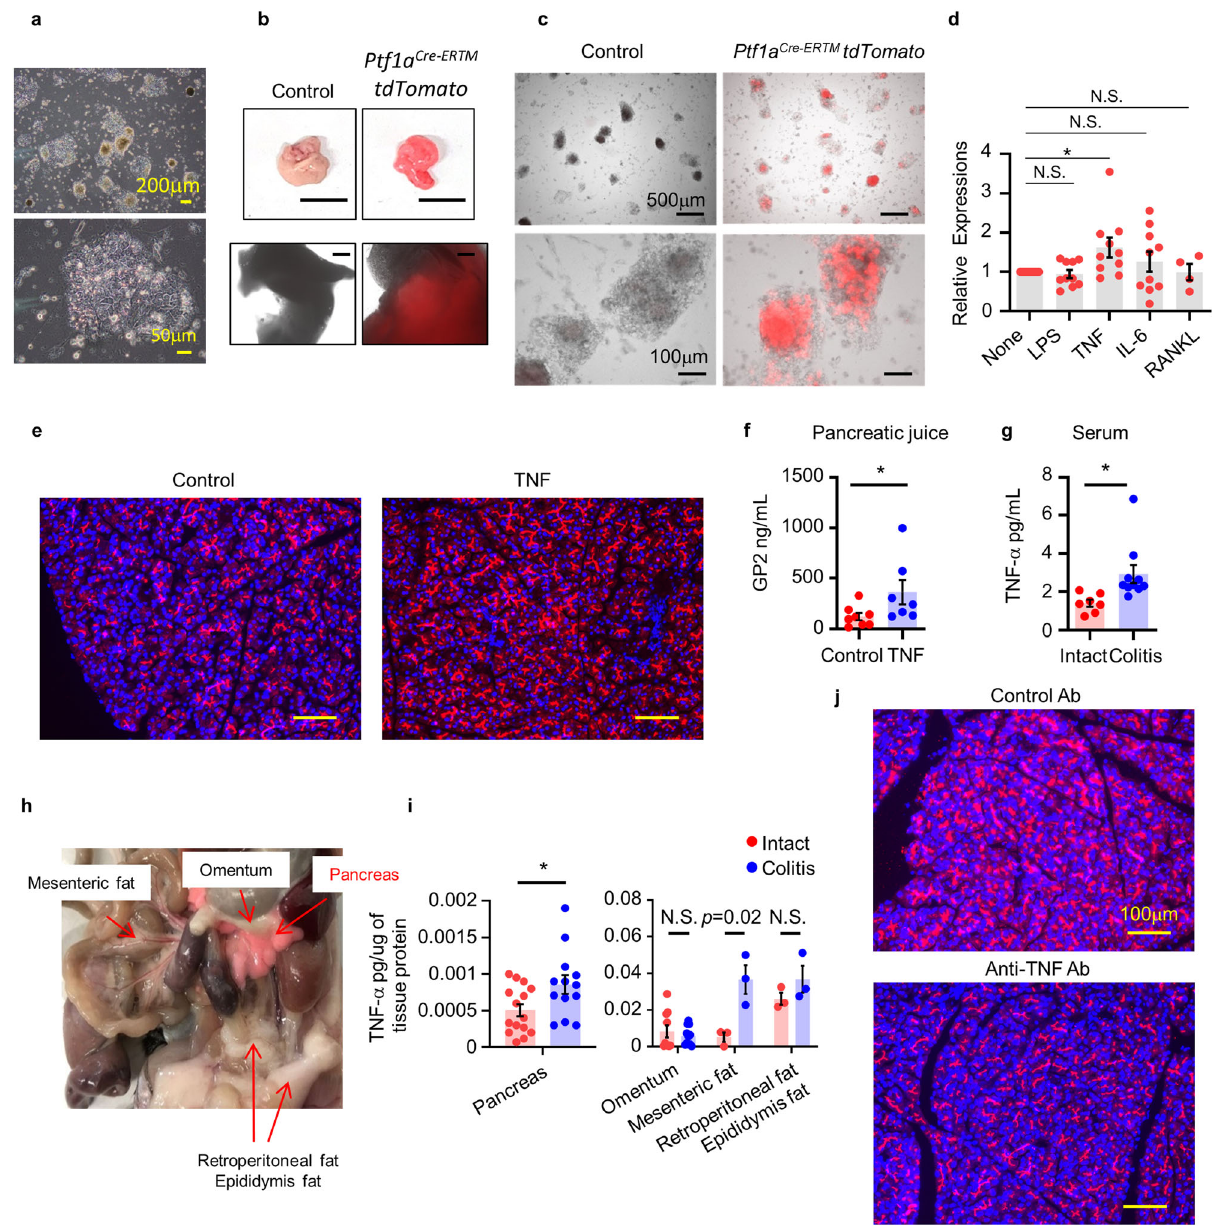
Fig. 3 In fl ammatory signal upregulates Gp2 expression in pancreatic acinar cells. a Cultured pancreatic acinar cells are shown. b Pancreas of control (upper) or Ptf1a Cre-ERTM Cre-tdTomato (bottom) mice received tamoxifen are shown. c Cultured pancreatic acini from control of Ptf1a Cre-ERTM -tdTomato mice stimulated with 4OHT are shown. Data are representing for three independent experiments. d Gp2 expression in no stimulation (None) or stimulated by 200 ng/mL LPS, 20 ng/mL TNF, 20 ng/mL IL-6 ( n = 10 /group), 100 ng/mL RANKL ( n = 4) pancreatic acini were examined. Relative expressions mRNA levels were determined by quantitative RT-PCR and normalized to Gapdh . * p = 0.040 (one-way ANOVA). Data are presented as mean values ± SEM., N.S. indicates not signi fi cant. e Pancreas of mice systemically administered PBS (control) or TNF (100 ng, two times). GP2 (red), DAPI (blue). Representative data of three independent experiments are shown. f GP2 concentration in pancreatic juice. * p = 0.04 (two-tailed Mann – Whitney U test). Data are presented as mean values± SEM. g TNF concentration in serum * p = 0.021 (two-tailed unpaired t -test). Data are presented as mean values ± SEM. h Representative photograph showing the abdominal-organ matrices surrounding the pancreas in Ptf1a Cre-ERTM -tdTomato mice that received tamoxifen. i TNF concentration in abdominal-organ matrices, as determined by enzyme-linked immunosorbent assay. Pancreas (intact n = 15, colitis n = 13), Omentum (intact n = 10, colitis n = 11) mesenteric fat (intact n = 15, colitis n = 13), Retroperitoneal fat and Epididymis fat (intact n = 3, colitis n = 3) * p < 0.05 (two-tailed unpaired t -test). Data are presented as mean values ± SEM. j 100 μ g of anti-TNF antibody (Biolegend, MP6-XT22, #506332) or Isotype Rat IgG2a (Biolegend, RTK2758, #400503) was intraperitoneal administered three times (on days 1, 3, and 5) during DSS treatment, and pancreases were collected on day 6. GP2 (red), DAPI (blue). Representative data of three independent experiments are shown. Source data are provided as a Source Data fi